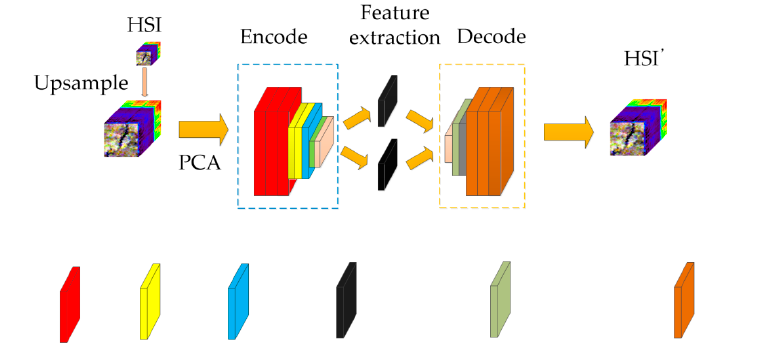
Figure 3. Feature extraction with MVAE for HSI